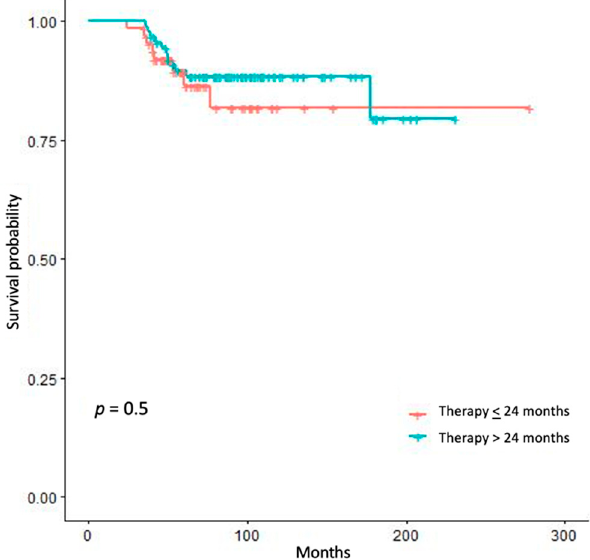
Figure 2. Kaplan–Meier estimates of recurrence-free survival (RFS) in patients treated <24 months versus patients treated >24 months.